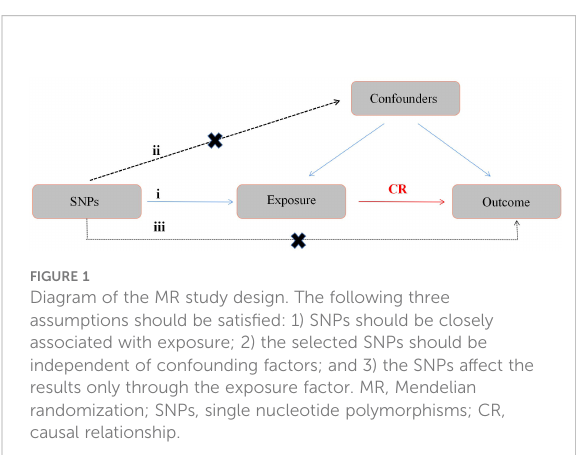
FIGURE 1 Diagram of the MR study design. The following three assumptions should be satis fi ed: 1) SNPs should be closely associated with exposure; 2) the selected SNPs should be independent of confounding factors; and 3) the SNPs affect the results only through the exposure factor. MR, Mendelian randomization; SNPs, single nucleotide polymorphisms; CR, causal